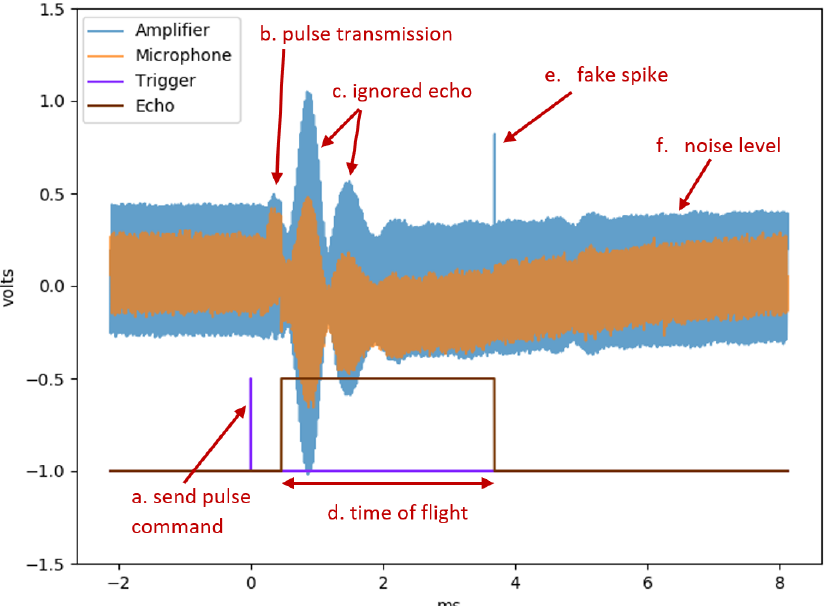
Figure 3. The result of monitoring the microphone (receiver) and the first amplifier ( amplifier 1 ), which is connected directly to the microphone’s output, as the attack is in progress and a fake object is detected at a distance of 55 cm (when there was no real object within the sensor’s range). This anomaly of ampli f ier 1 results in a fake echo detected by the sensor. The echo’s digital signal ((d) in Figure 3) is the output of the sensor, and the falling edge indicates the time of the returning echo. The timing of the anomaly (at (e)) is aligned with the timing of the fake echo (at (d)). To summarize, we detect a fake pulse in the output of the first amplifier, which causes the sensor to detect it as a real